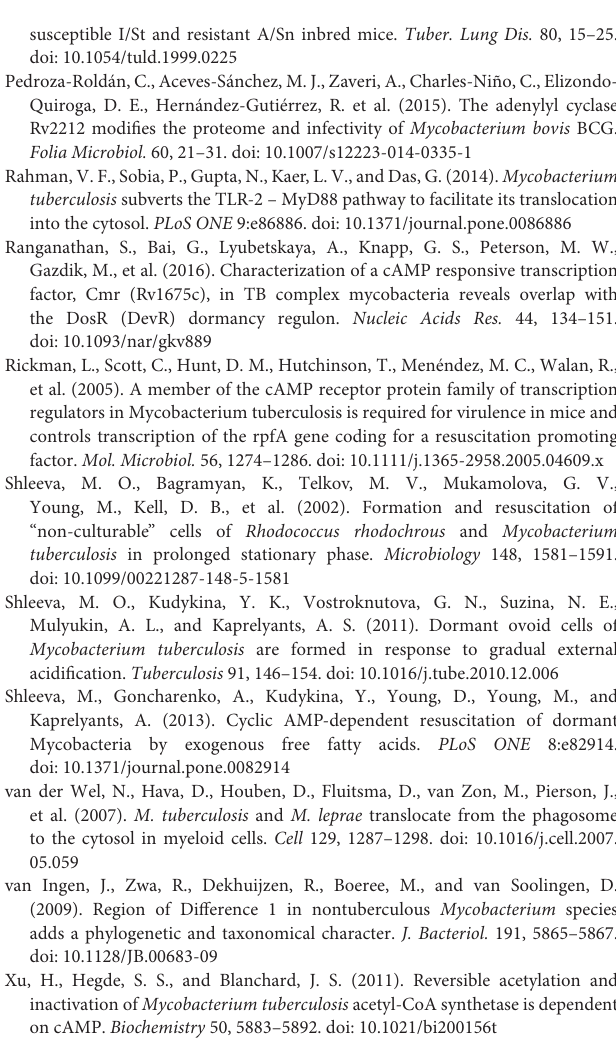
strains containing pMind Rv2212 vector (closed circles) or empty pMind vector (open circles) were cultured in the standard Sauton’s medium with agitation (200 rpm) at 37 ◦ C. Initial size of inoculum was 10 5 bacteria per ml. This experiment was repeated 3 times with similar results, one representative experiment is